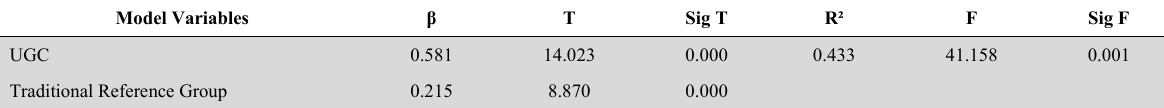
Simple regression test results for the second hypothesis Model Variables β T Sig T R² F Sig F UGC 0.581 14.023 41.158 0.001 Traditional Reference Group 0.215 8.870